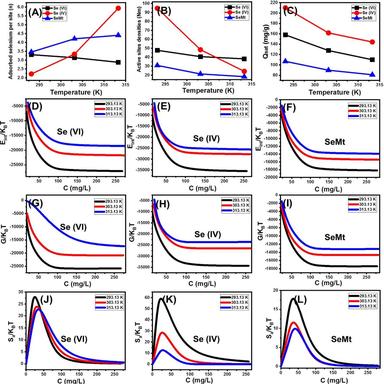
Shows the changes in the adsorbed selenium per site at different temperature (A), changes in the active sites densities of CF/ZA at different temperature (B), changes in the selenium saturation adsorption capacity at different temperature (C), changes in the internal energy values at different concentrations (D, E, and F), changes in the free enthalpy values at different concentrations (G, H, and I), and changes in the entropy values at different concentrations (J, K, and L).